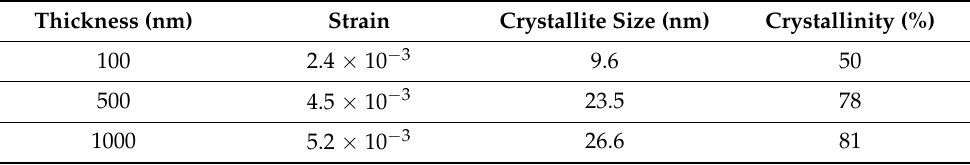
Figure 3. XRD spectra of the TiO 2 films with film thicknesses of 100 nm, 500 nm, and 1000 nm. All peaks are indexed to the anatase phase of TiO 2 . Table 1. Strain, crystallite size, and crystallinity of the TiO 2 films with 100 nm, 500 nm, and 1000 nm film thicknesses.